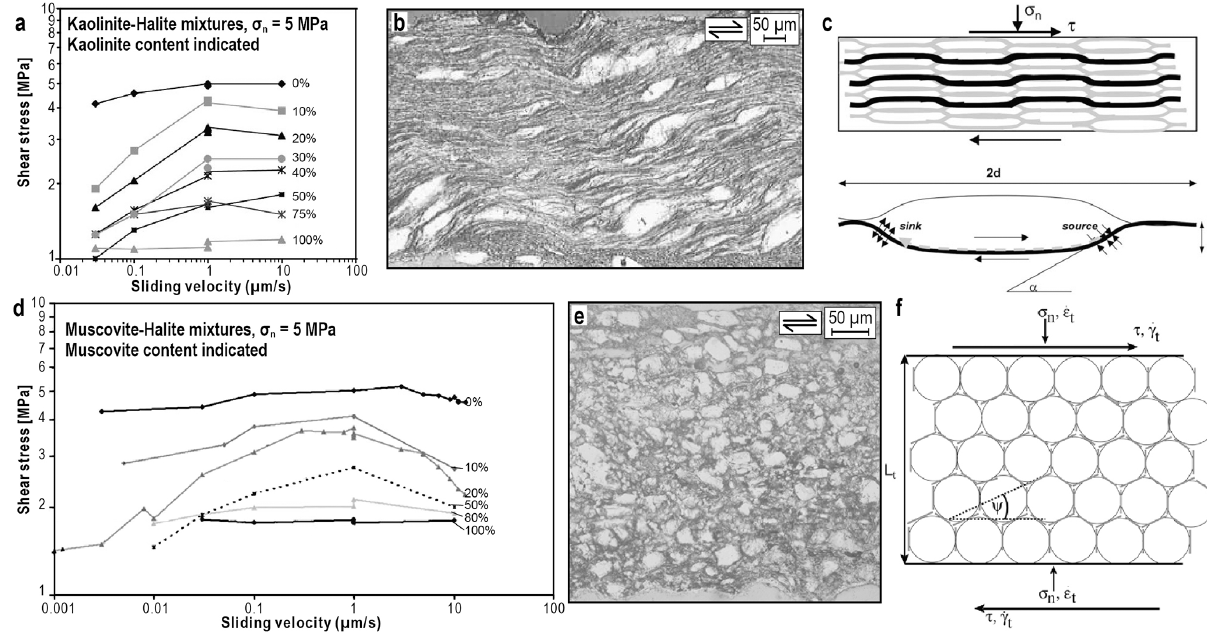
Figure 3. Data from ring-shear experiments on halite–phyllosilicate mixtures conducted at room temperature. (a, b) Halite–kaolinite mix- tures deformed in the v -strengthening frictional–viscous regime (adapted from Bos et al., 2000b – license no. 4656341028661). (c) Model microstructure for v -strengthening frictional–viscous flow (taken with publisher’s permission from Bos and Spiers, 2002a). σ n : normal stress; τ : shear stress; α : the angle between the leading edge of the halite grain and the horizontal; h : amplitude of the foliation; d : grain size (long axis). (d) Velocity dependence effects in halite–muscovite gouges (adapted from Niemeijer and Spiers, 2006 – license no. 4656330624652), with (e) a sample deformed in the v -weakening regime (taken with publisher’s permission from Niemeijer and Spiers, 2005). (f) Model microstructure for v -weakening granular flow (taken with publisher’s permission from Niemeijer and Spiers, 2007). ˙ ε t : macroscopic normal strain rate; ˙ γ t : macroscopic shear strain rate; ψ : dilatation angle; L t : thickness of the deforming zone; other symbols are the same as in (c)